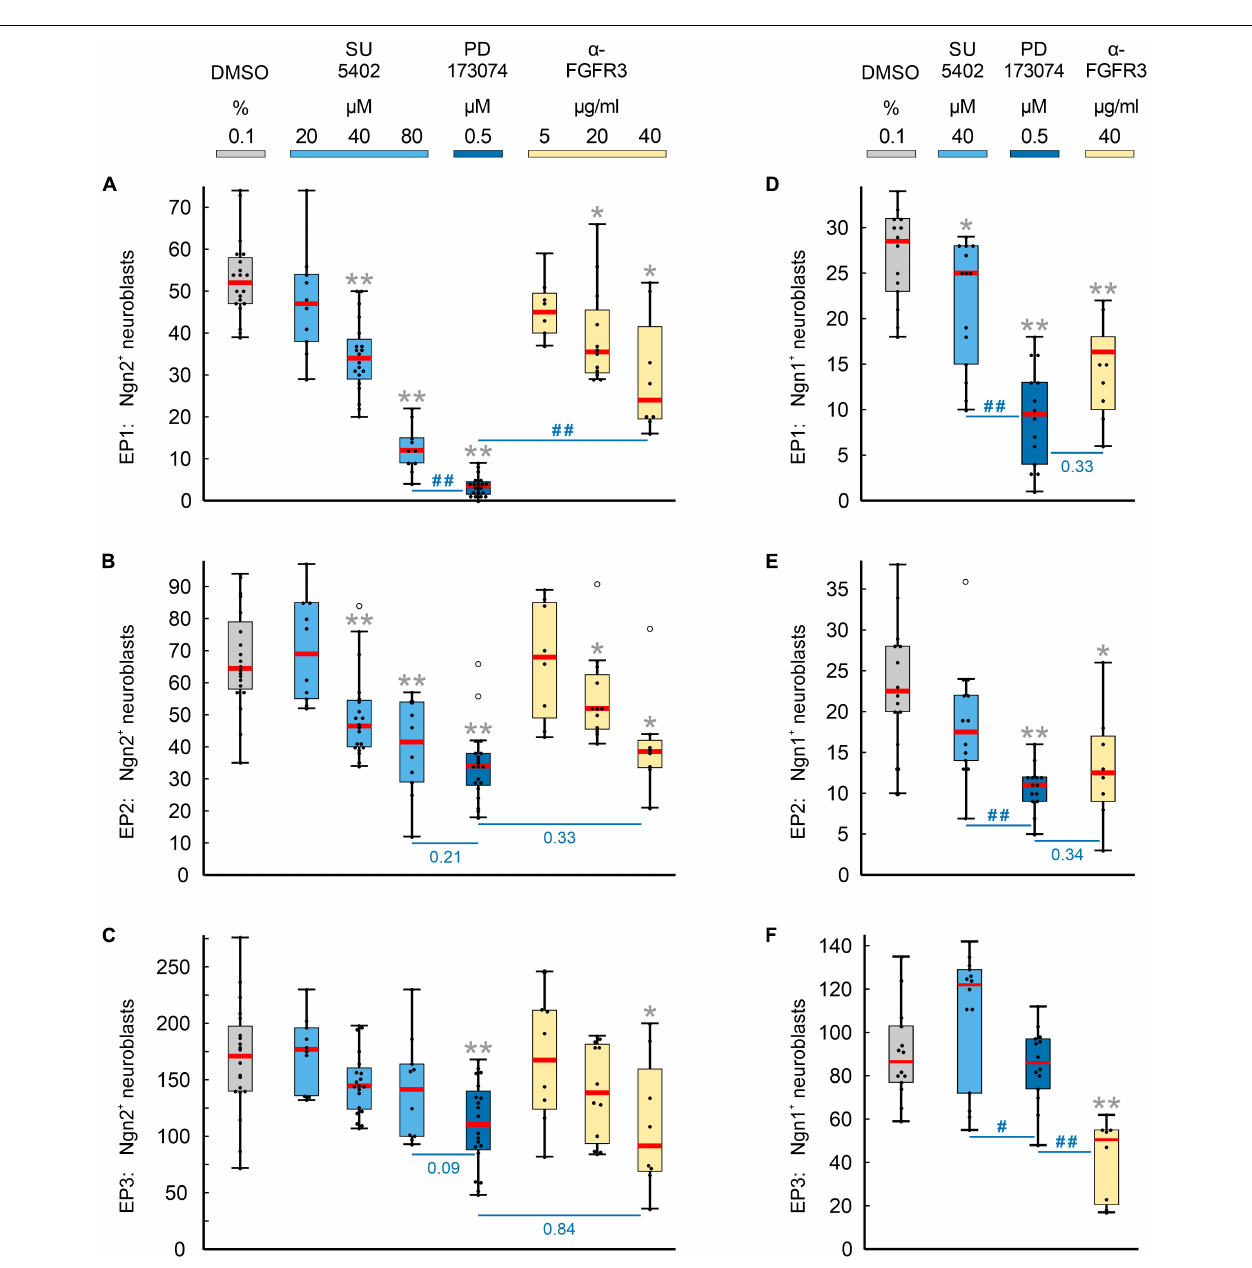
FIGURE 4 | Impact of FGFR inhibition on the neurogenesis of epibranchial placodes (EP) in 9–14 somite mouse embryos, cultured for 24 h. Box plots indicate the numbers of Neurogenin (Ngn)2 + (A–C) or Ngn1 + (D–F) neuroblasts in EP1 (A,D) , EP2 (B,E) , or EP3 (C,F) following exposure to either dimethyl sulfoxide (DMSO) only (control; gray), or increasing doses of pan-FGFR inhibitor SU5402 (light blue), or 0.5 µ M of pan-FGFR inhibitor PD173074 (dark blue), or increasing concentrations of anti-FGFR3 neutralizing antibodies (yellow). Significant differences between each treatment group and the controls are indicated by gray asterisks (* P < 0.05, ** P < 0.001; Mann–Whitney test). Additionally, PD173074-treated embryos were compared to groups exposed to either highest levels of SU5402 or anti-FGFR3 antibodies (significant differences: # P < 0.05, ## P < 0.001; or specific P values, respectively). Whiskers, lower and upper extremes; box limits, 25th and 75th percentiles; red center lines, medians; black dots, data points; open circles,